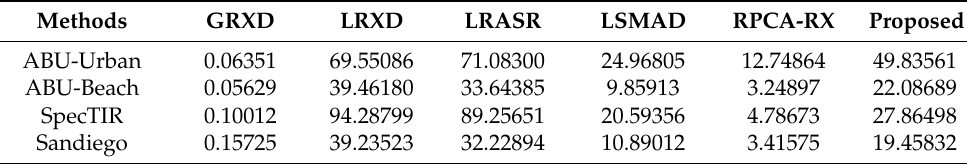
Table 3. The running time (unit:s) of different methods using four experimental datasets.